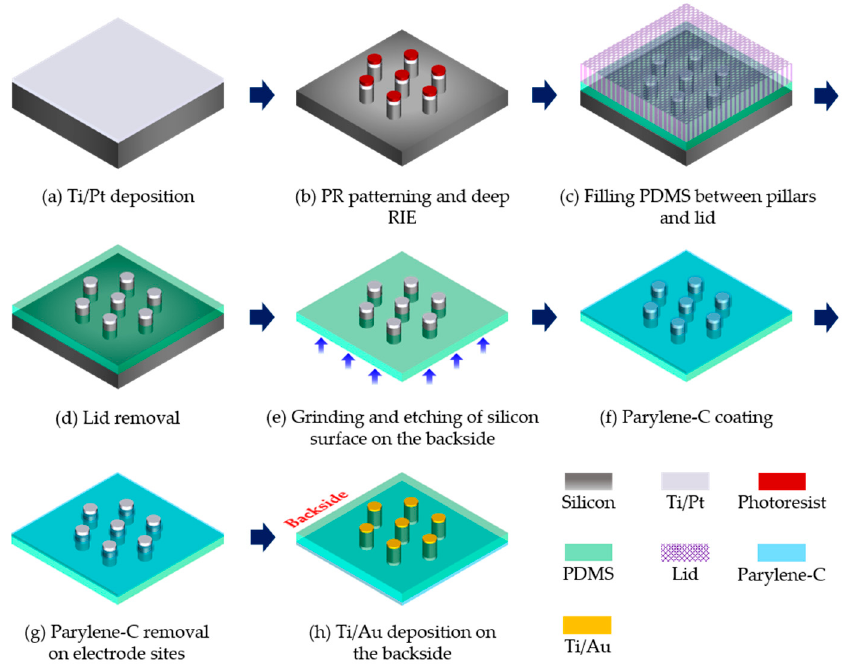
Figure 2. Schematic diagram of the main processes to fabricate the 3D microelectrodes in a hexagonal arrangement.